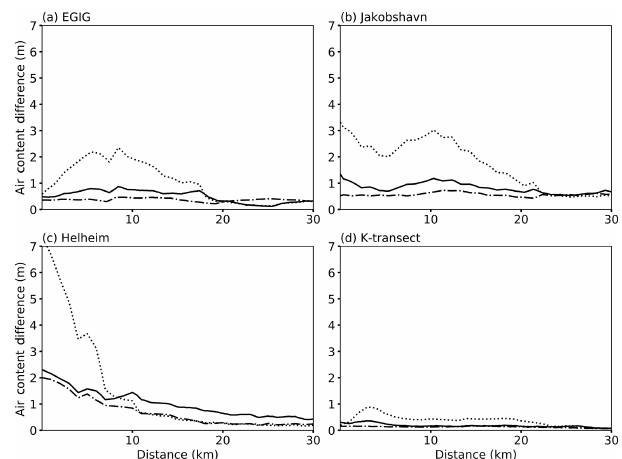
Figure 4. Simulated difference between integrated firn air content 2D and 1D modeling schemes in the lowest 30km of (a) EGIG, (b) Jakobshavn, (c) Helheim, and (d) K-transect. Differences are presented for each meltwater infiltration scheme: Reeh et al. (2005) (dotted), bucket method (solid), and continuum